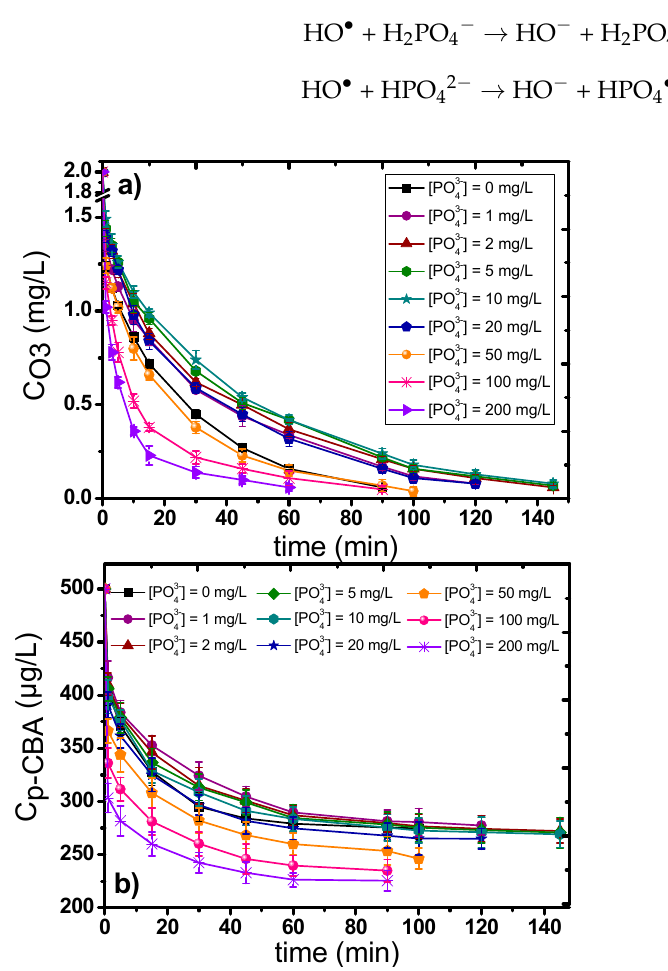
Figure 5. Influence of PO 43 − concentration on ( a ) ozone decomposition, and ( b ) p-CBA removal in the Co(II)/O 3 catalytic ozonation process. Experimental conditions: initial p-CBA concentration 500 μ g/L, ozone concentration 2 mg/L, catalyst concentration 1 mg/L, pH 7.8, temperature 23 ± 2 °C.